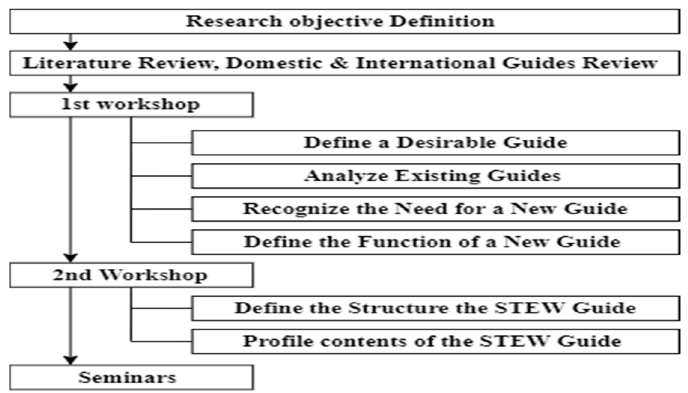
Figure 3. Research